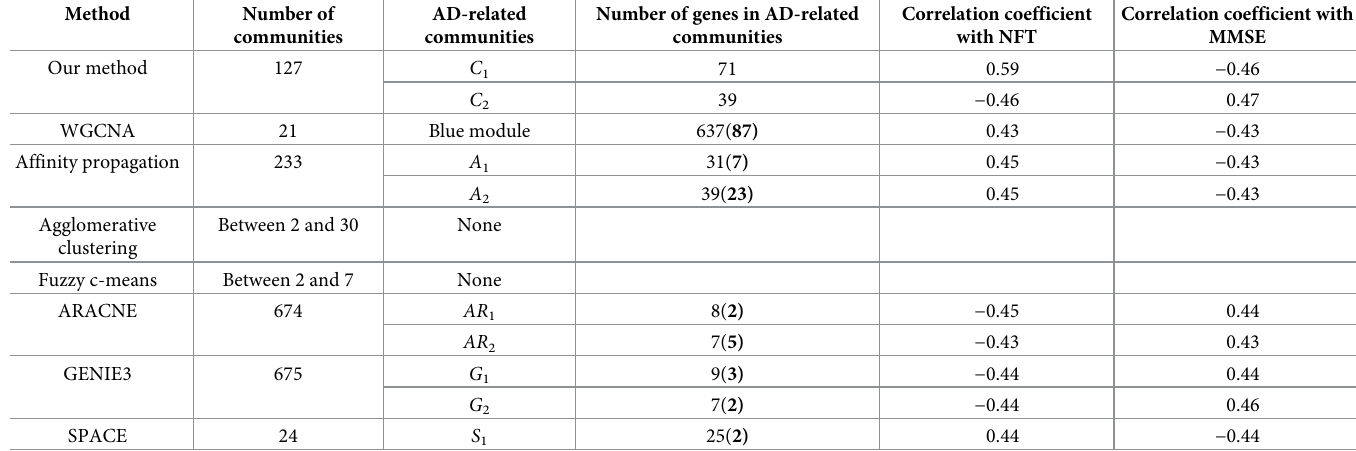
Table 4. Summary table of the results obtained through the proposed community detection methods. In the fourth column the number of genes in common with C 1 and C 2 communities is shown in bold. We reported only significant correlations ( p - value <